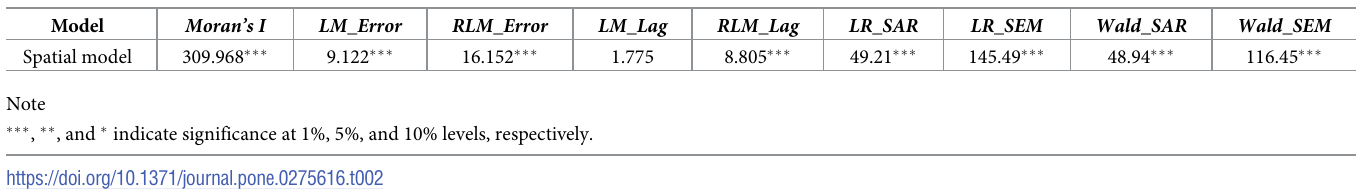
Table 2. Spatial econometric model